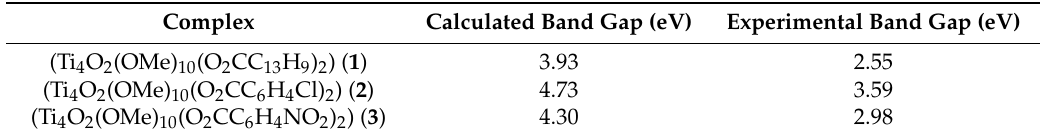
Table 5. Comparison of experimentally determined band gap values (using diffuse reflectance spectra), and theoretically calculated (HSE06/6-31(d,p) level of theory in calculations of ( 1 )–( 3 ) complexes the O i Bu ligands were exchanged on the OMe one).